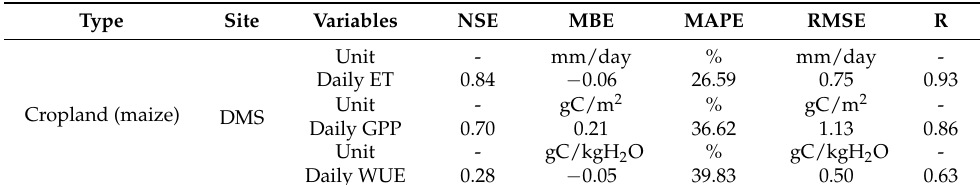
Table 2. Statistics for model validations to estimate daily ET, GPP, and WUE for cropland (maize)